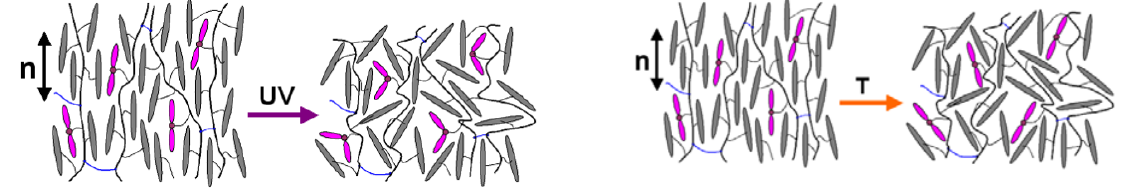
Figure 3. Schematic illustration of the effect of UV-light-induced trans- to- cis isomerization (left) and heating (right) on the orientational order of a liquid crystal elastomers (LCE). Pink colored double ellipsoids denote azomesogenic side groups and gray colored ellipsoids denote usual mesogenic side groups. Black lines denote polymer chains and blue lines denote cross-links between them. Both isomerization and heating produce a decrease of the LC order parameter S. Consequently, contraction of the film in the direction of the nematic director n and elongation in the direction perpendicular to n take